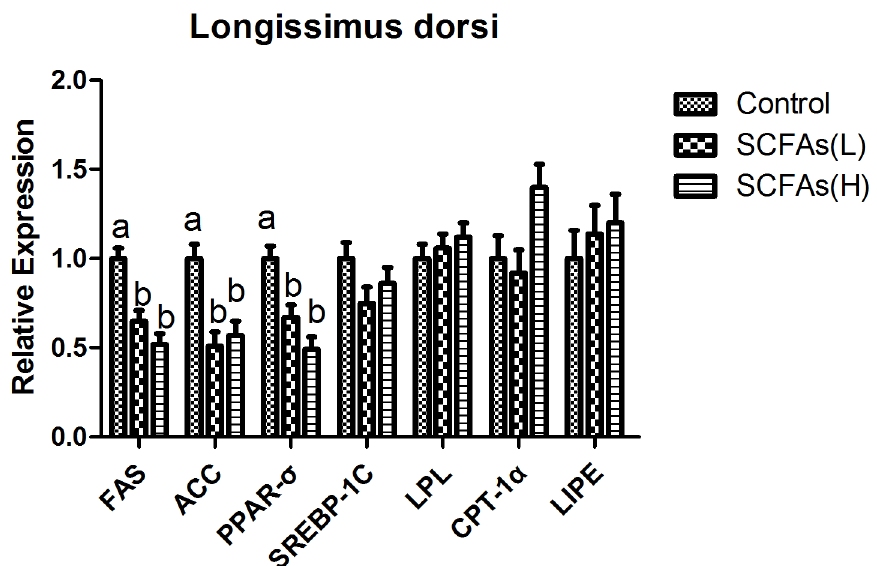
Fig 2. Effects of SCFAs on mRNA expressions for key factors related to lipid metabolism in longissimus dorsi over the experimental period of weaned pigs. SCFAs (L): acetic acid 20.04 mM, propionic acid 7.71 mM and butyric acid 4.89 mM; SCFAs (H) :acetic acid 40.08 mM, propionic acid 15.42 mM and butyric acid 9.78 mM. FAS fatty acid synthase; ACC acetyl-CoA carboxylase; PPAR peroxisome proliferator activated receptor; SREBP-1C sterol regulatory element binding protein 1C; LPL lipoprotein lipase; CPT-1 α carnitine palmitoyltransferase-1 α ;LIPE lipase hormone- sensitive. a-b Within a row, means without a common superscript differ (P < 0.05).